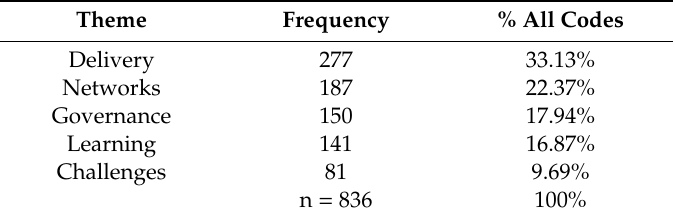
Table 7. Rank-ordered code category by frequency.